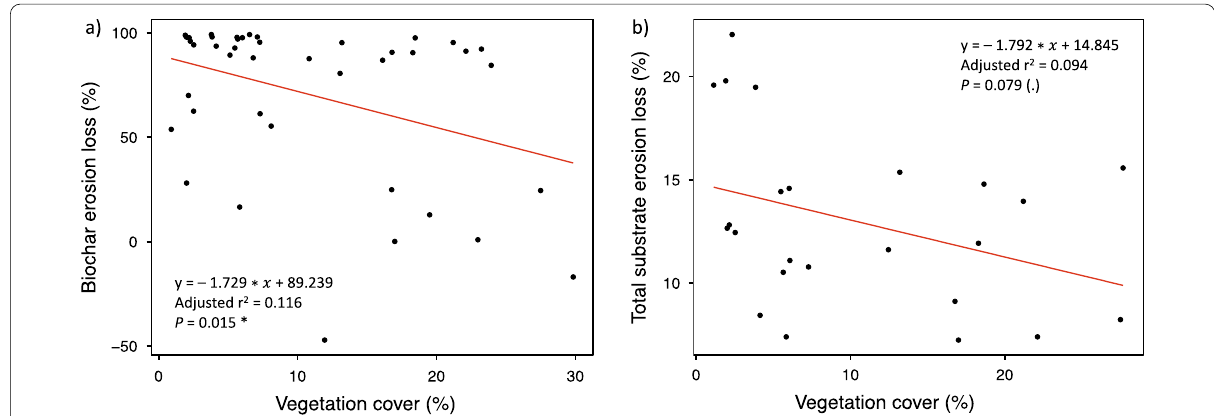
Fig. 6 Relationship between vegetation cover in October 2019 and biochar erosion ( a ) and total substrate erosion ( b ). Lines indicate fitted linear regression models (n 42 for biochar erosion and n 24 for substrate erosion). Asterisks indicate significance of models: (.), P < 0.1; * P < = =